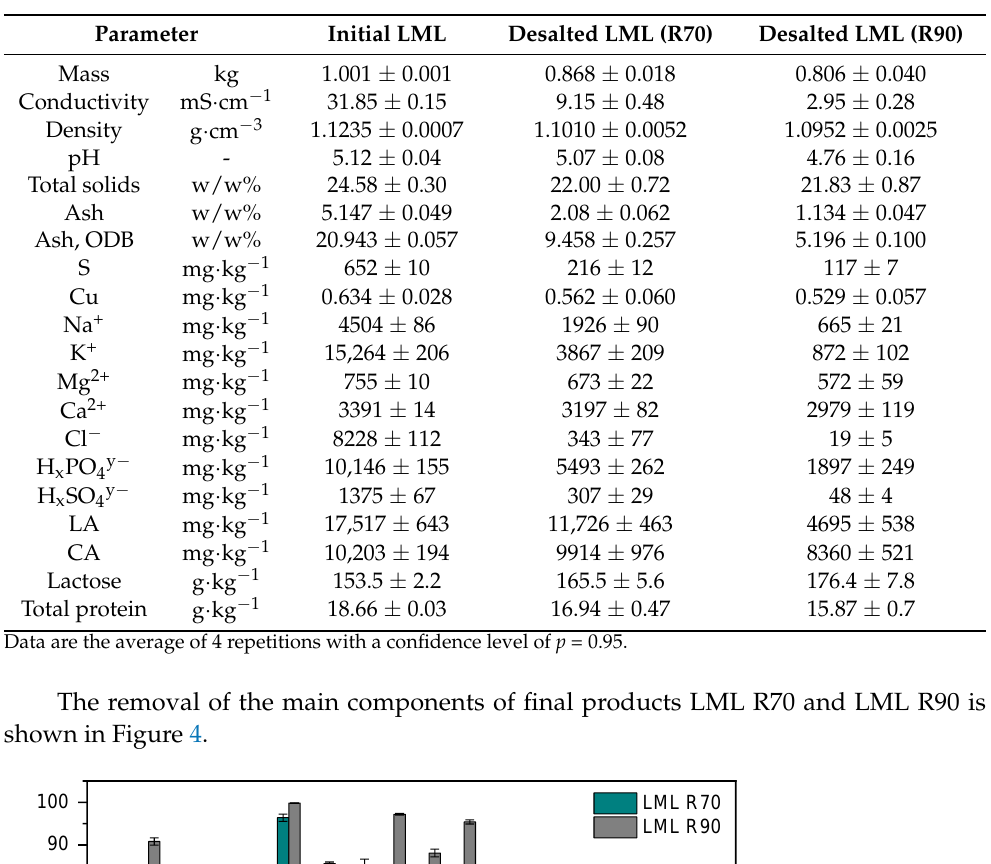
Table 3. Conductivity, pH, mineral and organic composition of initial and desalted LML samples. Parameter Initial LML Desalted LML (R70) Desalted LML (R90)